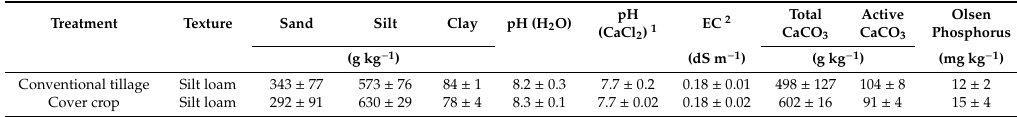
Table 1. Physical and chemical properties of soils (0–20 cm) measured in 2012, at grapevine flowering. Data are expressed as mean ± SD ( n =